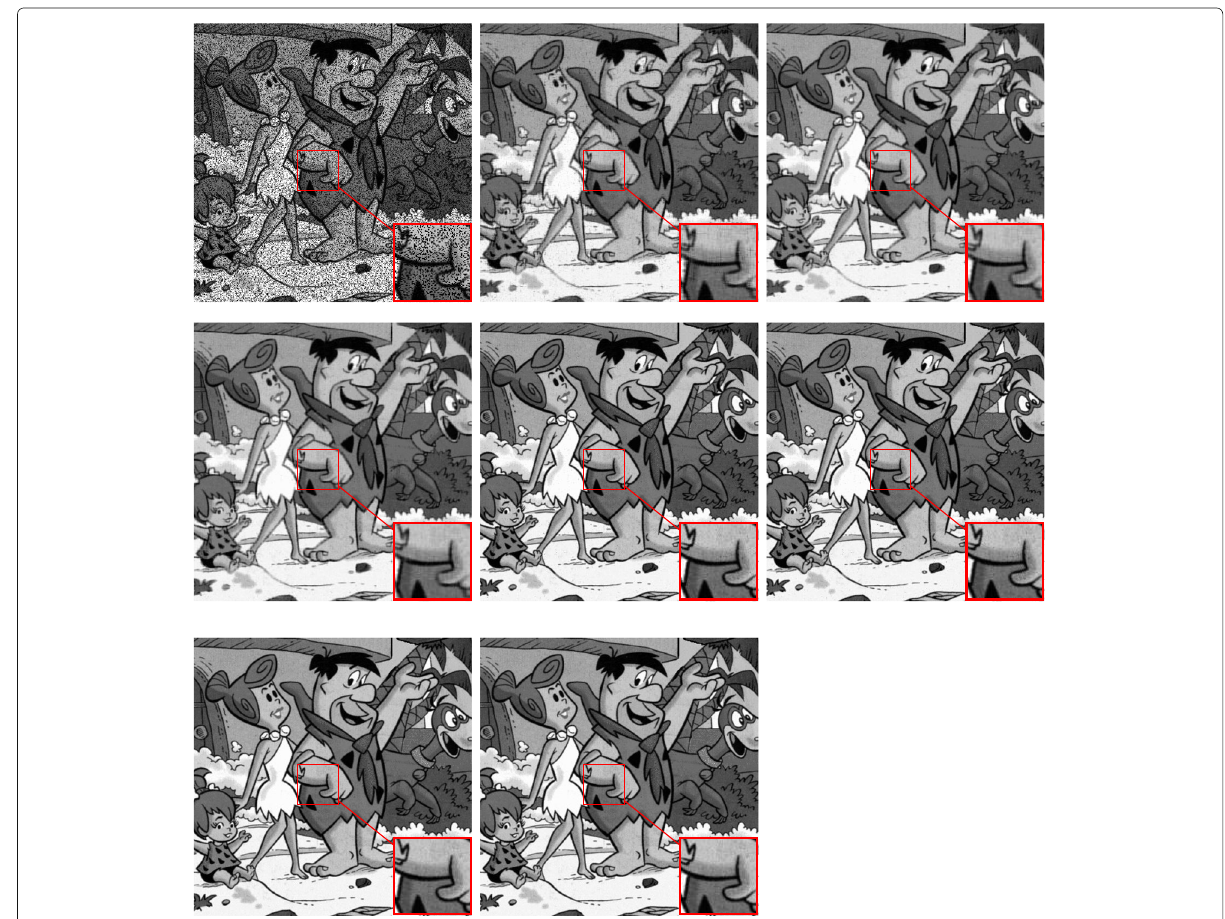
Fig. 4 Results obtained for image “flinstones” using the different methods. From left to right, the order of the images is as follows: simulated image with missing data, recovered image using FPC algorithm, recovered image using ALM algorithm, recovered image using IALM algorithm, recovered image using PPG algorithm, recovered image using PG algorithm, recovered image using SVT with power method, and finally the recovered image using our proposed